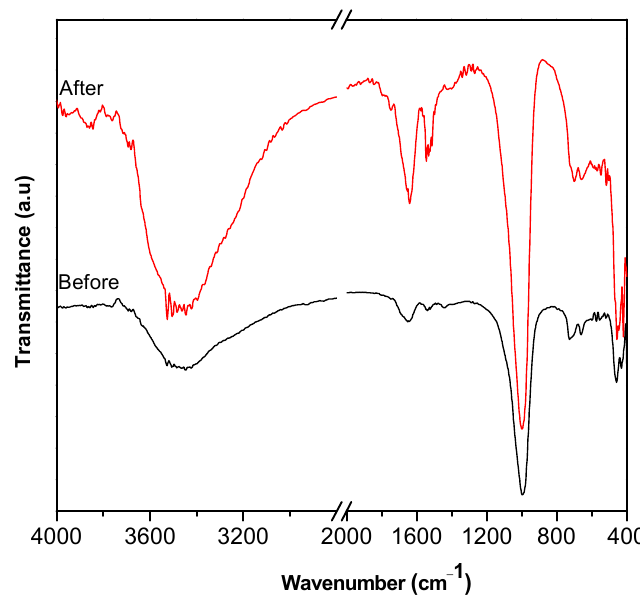
Figure 12. FTIR analysis of S80H9 before and after Pb 2+ adsorption.